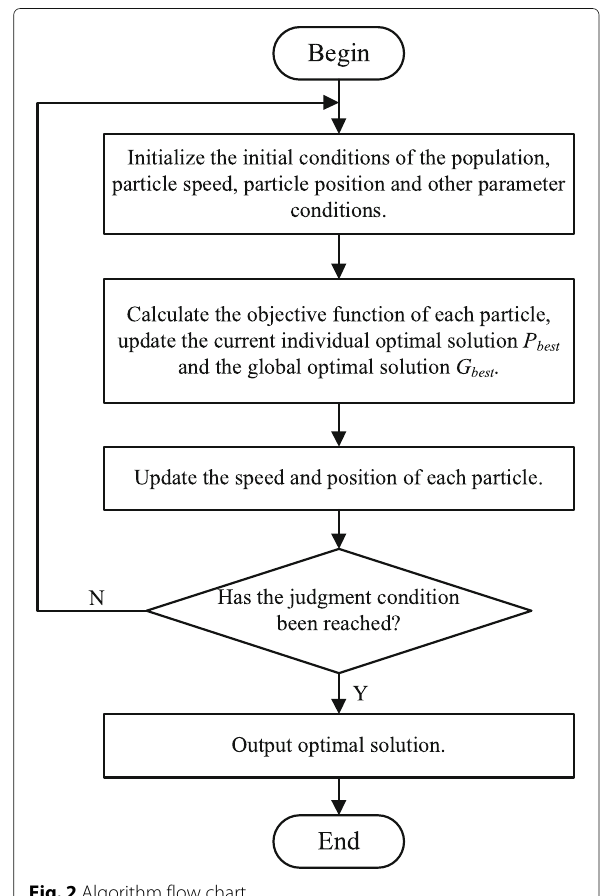
Fig. 2 Algorithm flow chart